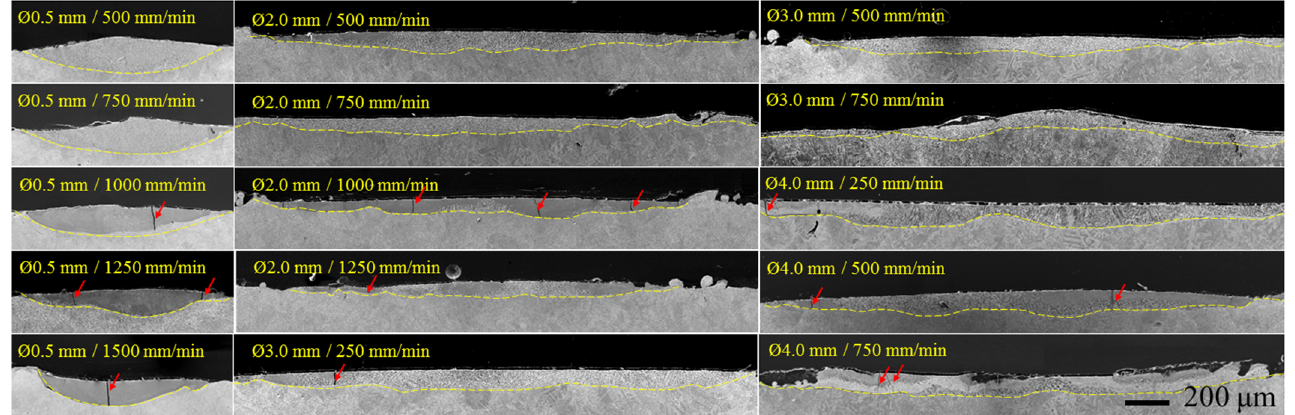
Figure 3. General view of the melt pools obtained by laser boronizing at different parameters; red arrows show the location of transverse cracks.